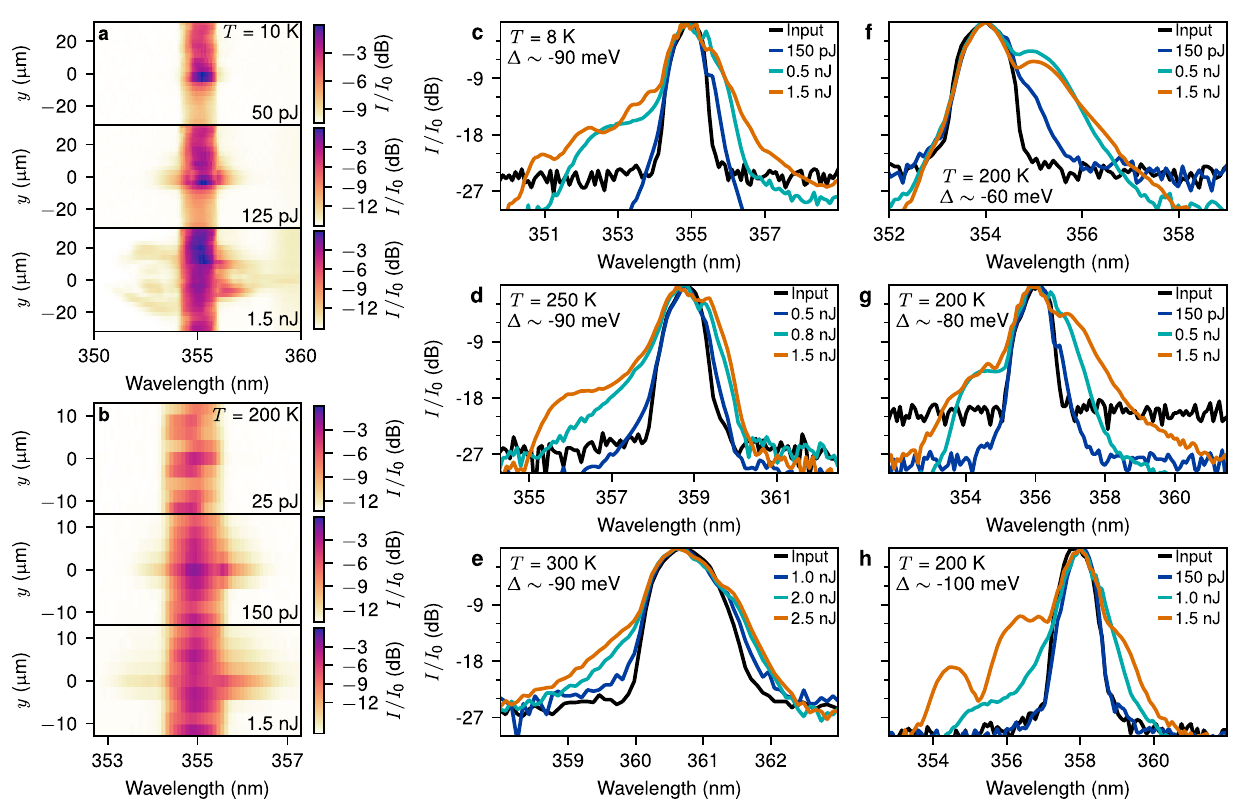
Fig. 3 Spectra after nonlinear pulse propagation. a , b Colour maps of the output intensity I relative to the peak I 0 vs. wavelength, λ , and position y transverse to the propagation direction for increasing pulse energy coupled into the waveguide and at temperatures T = 10 K ( a ) and at T = 200 K ( b ). The injected pulses had central wavelength λ = 355 nm and propagation distance L = 100 μ m. c – e Spectra integrated along y for a range of temperatures, T = 8 K ( c ), 250 K ( d ), and 300 K ( e ) all at pulse-exciton detuning Δ ~ − 90 meV. f – h Spectra integrated along the y -direction for a range of detunings Δ ~ − 60 meV ( f ), − 80 meV ( g ), and − 100 meV ( h ) all at T = 200